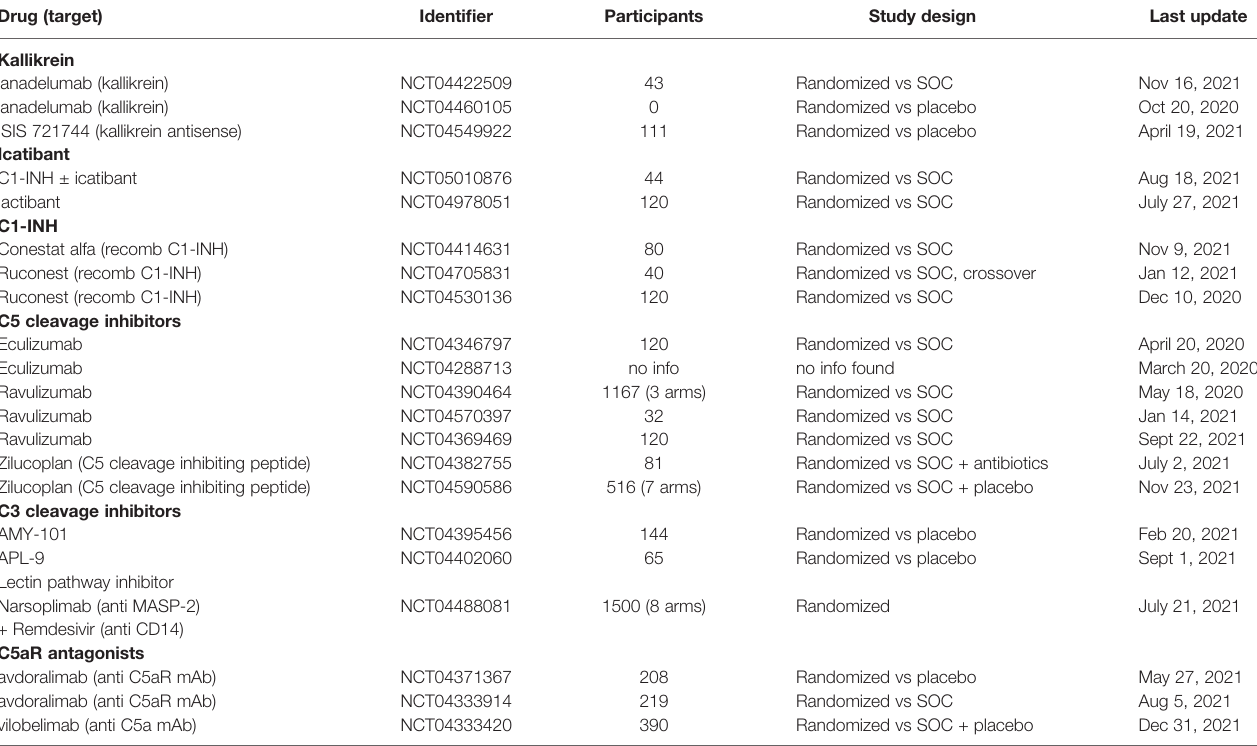
TABLE 1 | All trials currently (2022-01-28) registered in ClinicalTrials.gov testing targeting IIIS components in